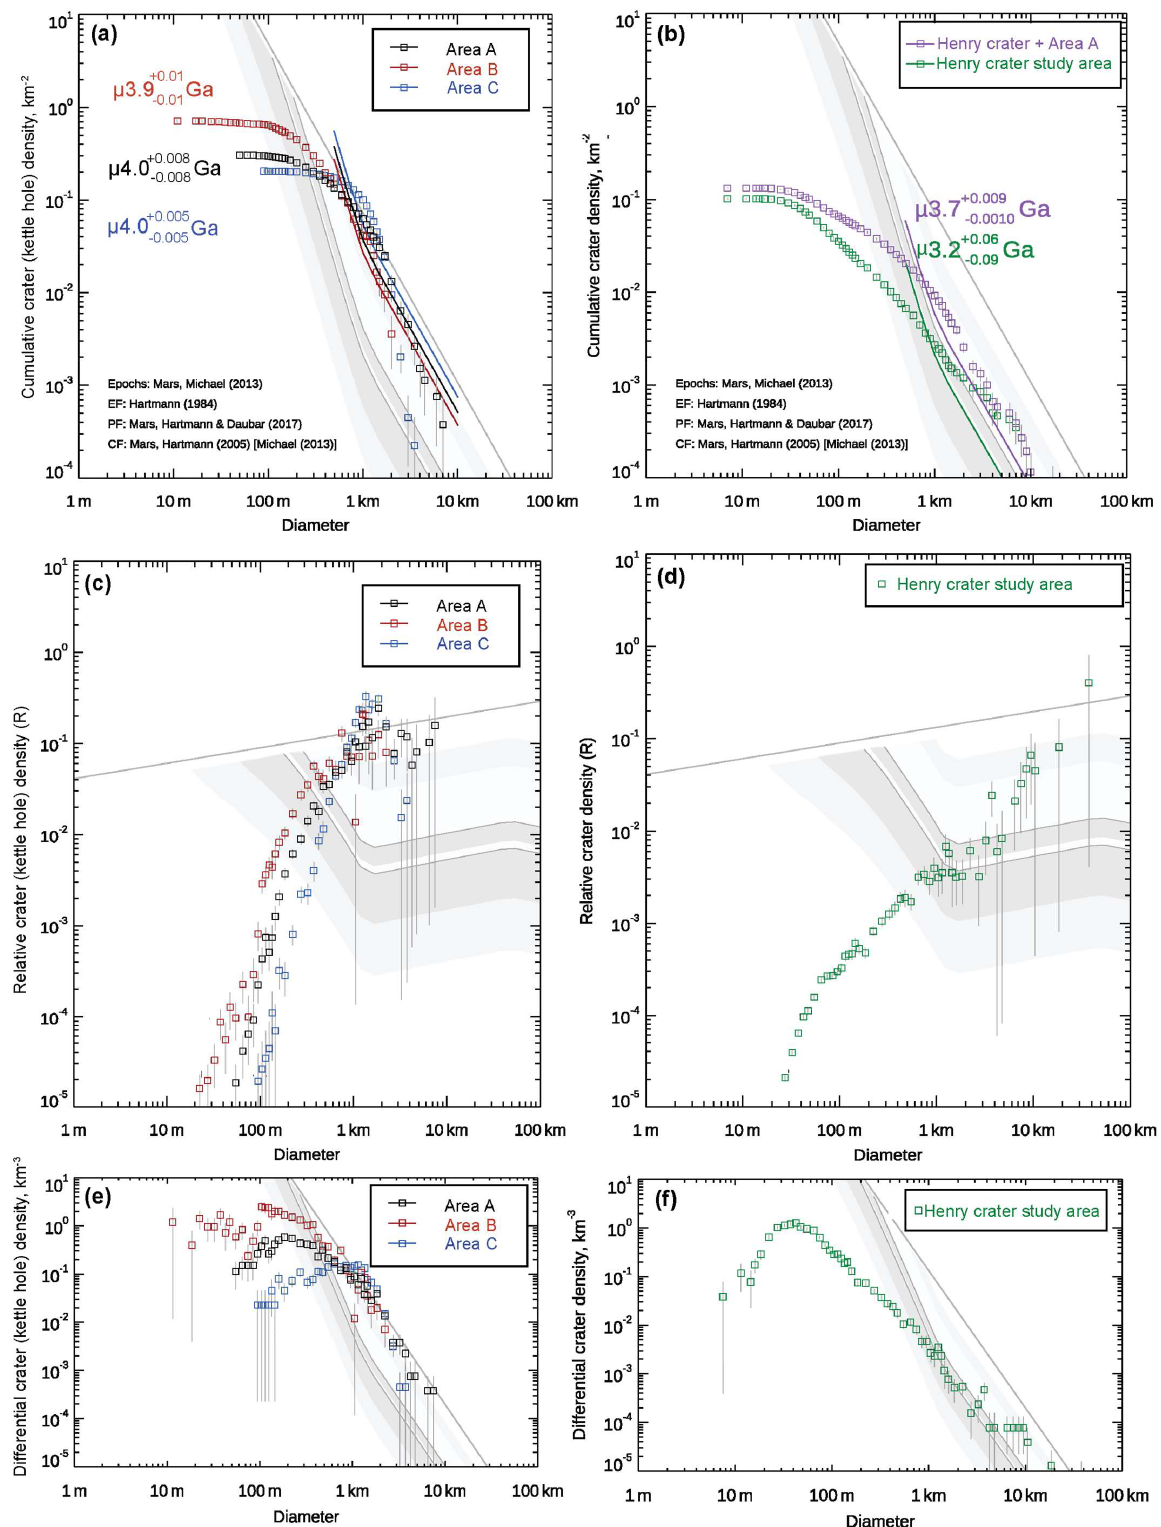
Figure 4. Size frequency distribution plots showing the populations of kettle holes in this study and craters in the Henry crater Martian study area. The cumulative size frequency distribution ( a , b ), was used to compare the feature distributions to Martian surface age isochrons and estimate a surface exposure age, assuming all the measured features were interpreted as craters. Ages for the kettle